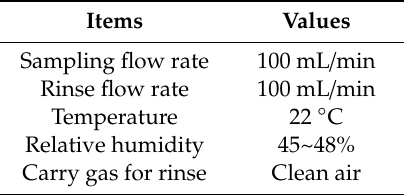
Table 2. Operational parameter of the E-nose system test.